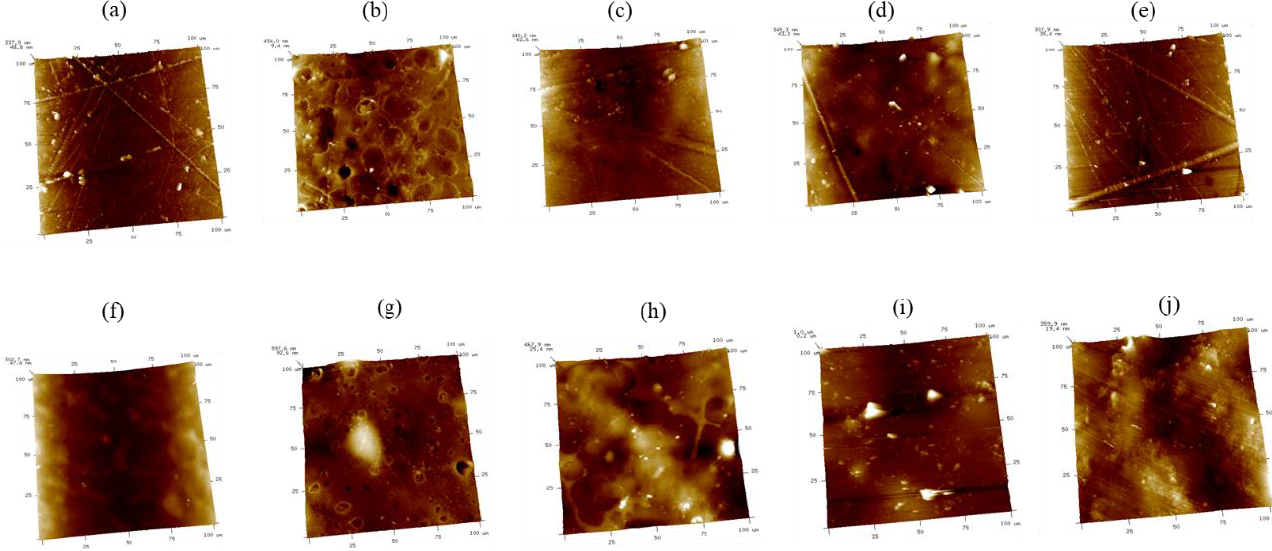
Figure 6. 3D topography of GA crosslinked and PEGDE crosslinked chitosan/HNa films. HNa 15% (Top, a – e ) and HNa 30% (bottom, f – j ); ( a ) CHT/HNa15, ( b ) CHT/HNa15%/PEDGE1, ( c ) CHT/HNa15%/PEDGE2, ( d ) CHT/HNa15%/PEDGE3, ( e ) CHT/HNa15%/GA, ( f ) CHT/HNa30%, ( g ) CHT/HNa30%/PEDGE1, ( h ) CHT/HNa30%/PEDGE2, ( i ) CHT/HNa30%/PEDGE3, ( j )